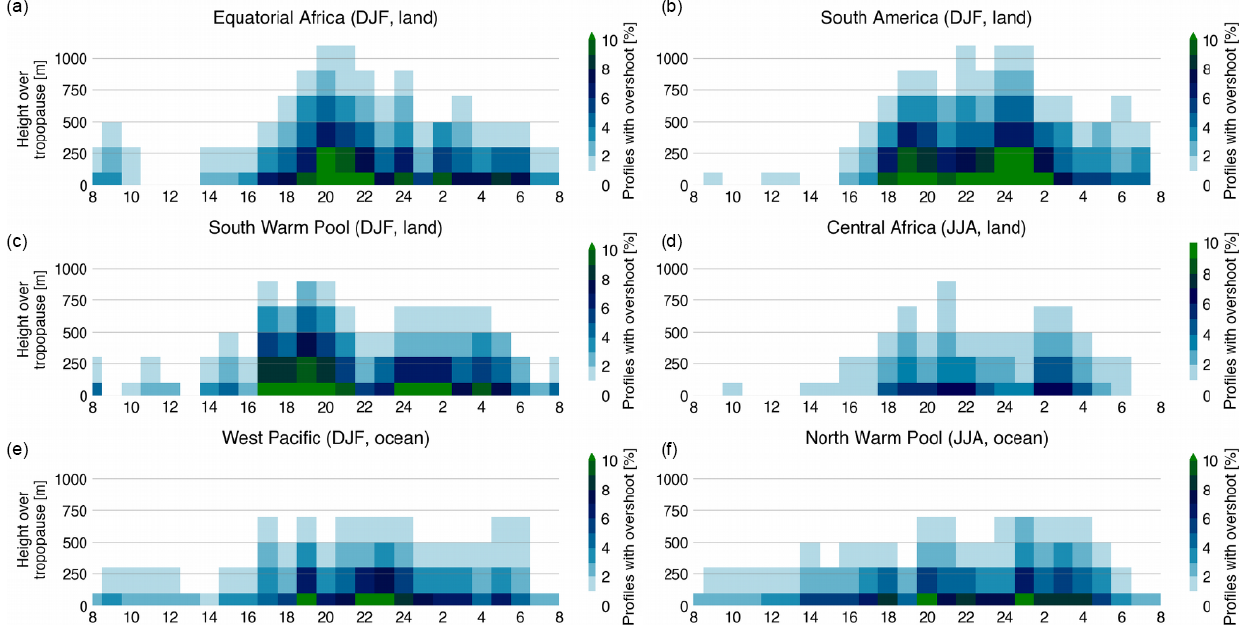
Figure 3. Diurnal cycle of cloud fraction as a function of height above the tropopause, by tropical region as in Fig. 1, in DJF (a, b, c, e) and JJA (d, f)